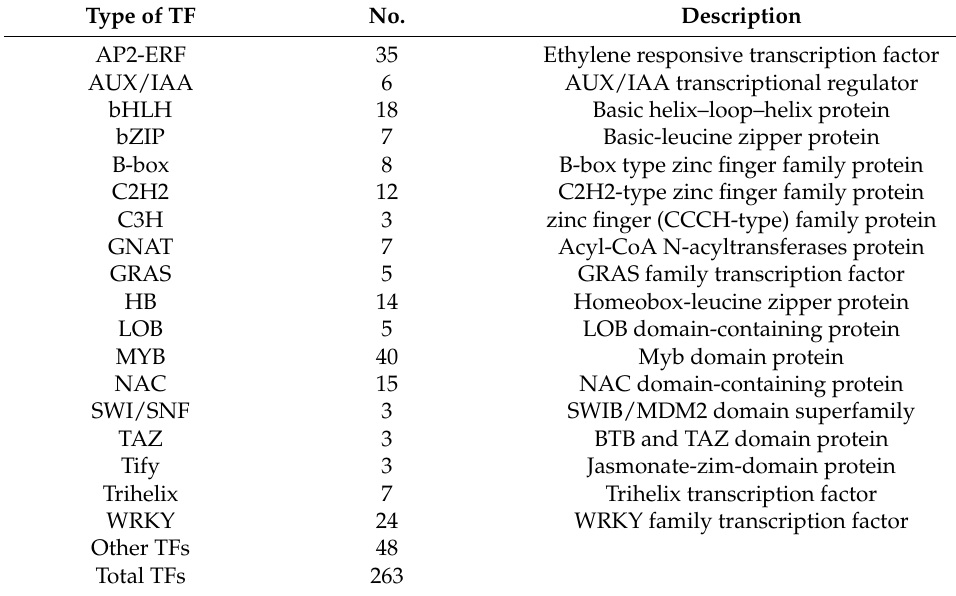
Table 1. Transcription factors in “Blue” and “Turquoise”